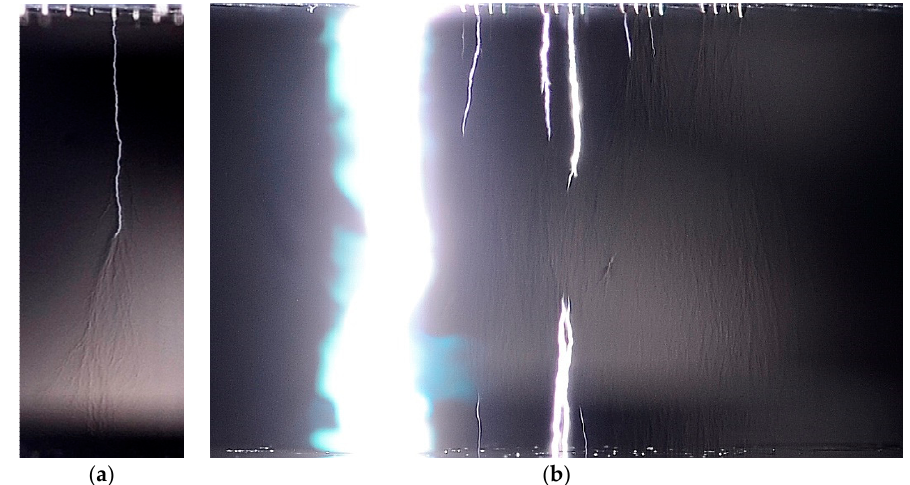
Figure 11. Images of partial discharges and breakdown in CO 2 at 0.6 MPa for ( a ) positive polarity at 115 kV / cm with 100- µ m protrusions and ( b ) negative polarity at 139 kV / cm with 200- µ m protrusions.